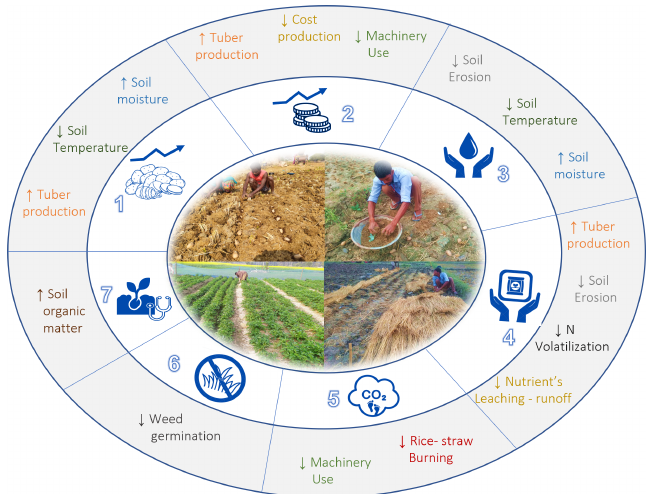
Figure 4. The main processes triggered by zero/minimum-tillage and/or mulching under potato cultivation reported by the literature that improve crop yield (1), profitability (2), nutrient-use efficiency (3), water productivity (4), C footprint (5), weed control (6) and soil organic carbon (soil health)